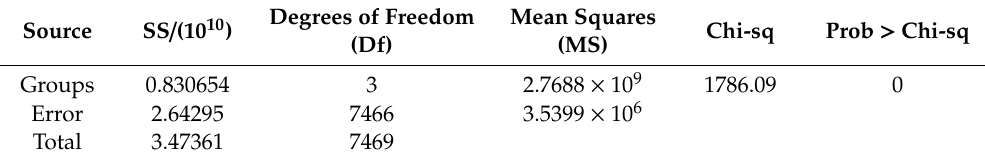
Table 6. Kruskal–Wallis ANOVA table for sleep position comparison.